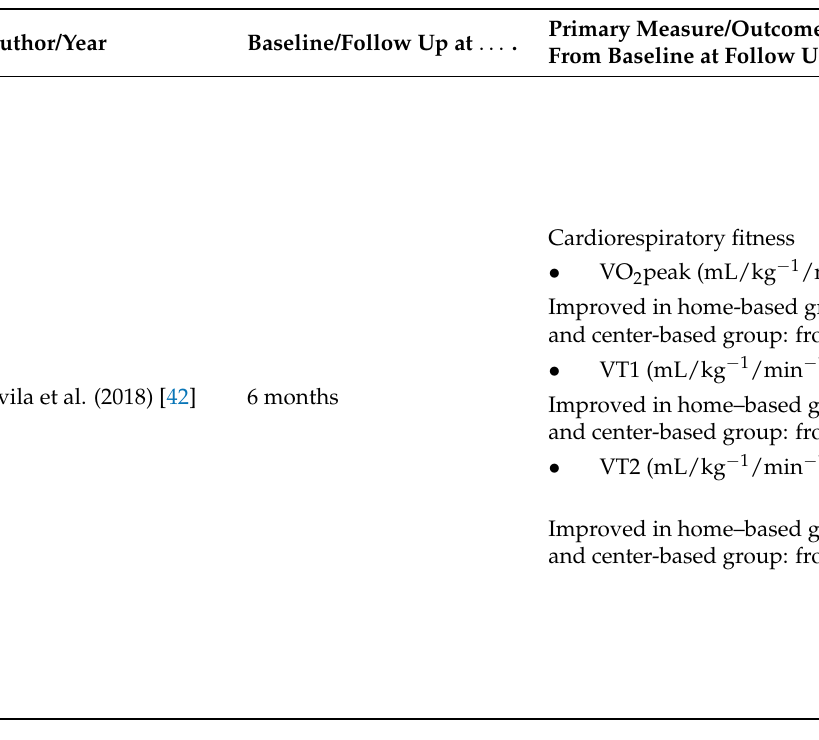
Table 2. Results reported in